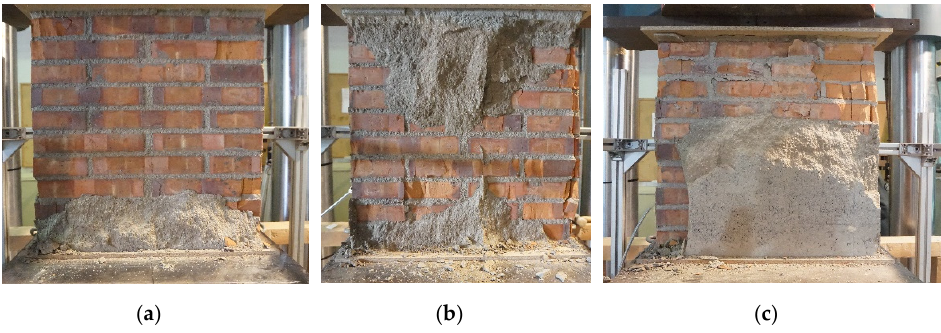
Figure 10. Front view of the sample after failure: ( a ) Mode A; ( b ) Mode B; ( c ) Mode C. Mode A: very little of the lower part of the sprayed layer is bonded to the brick wall, while the top part falls off. Mode B: the bottom half of the sprayed layer is bonded to the brick wall, while the top part comes off. Mode C: the sprayed layer is partially bonded to the brick wall at the top and bottom, showing an X pattern. Most samples followed Mode I and Mode A, which means that most samples failed at the interface. Furthermore, the left and right sides of these samples tended to follow different failure modes. Among them, both BMWSCA6 and BMWSCA11 followed Mode III, meaning that they showed overall crack damage along their lateral diagonal but not their interface. BMWSCA10-12–samples with both sides sprayed–all have different damage patterns on both front and back sides, for all samples produced a sound during the test due to failure. This may indicate that